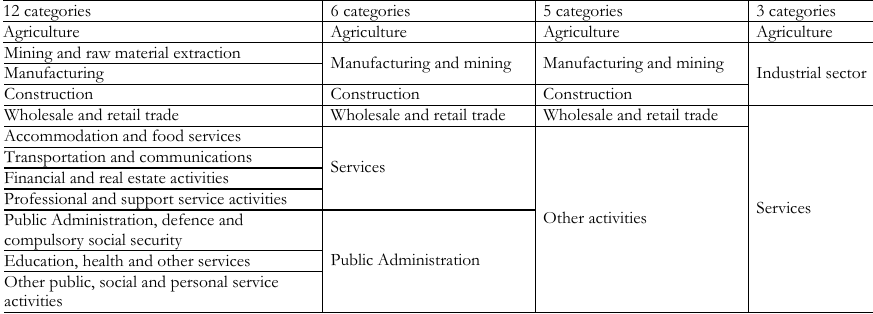
Scheme of categories aggregation process: